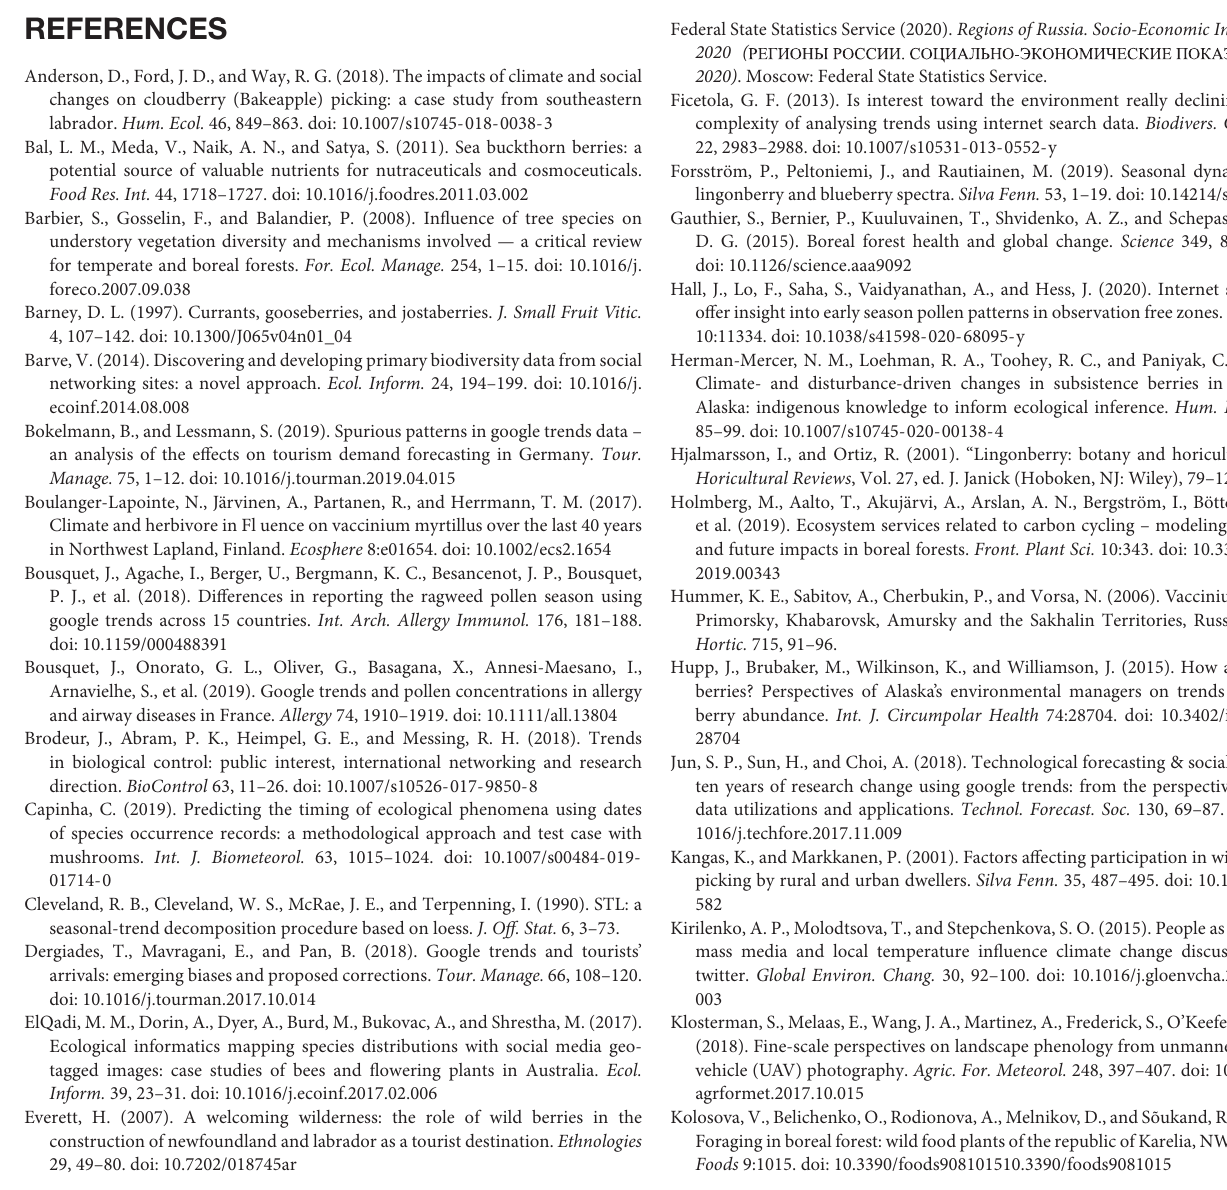
(C) bog bilberry, (D) European blueberry, (E) currant, (F) gooseberry, (G) cloudberry, (H) raspberry, (I) honeysuckle, and (J) sea buckthorn across Russia. Black lines indicate RSV without correction (same to Figure 3 ) and blue (computer), cyan (software), green (life), and red (love) are RSVs with benchmark correction.